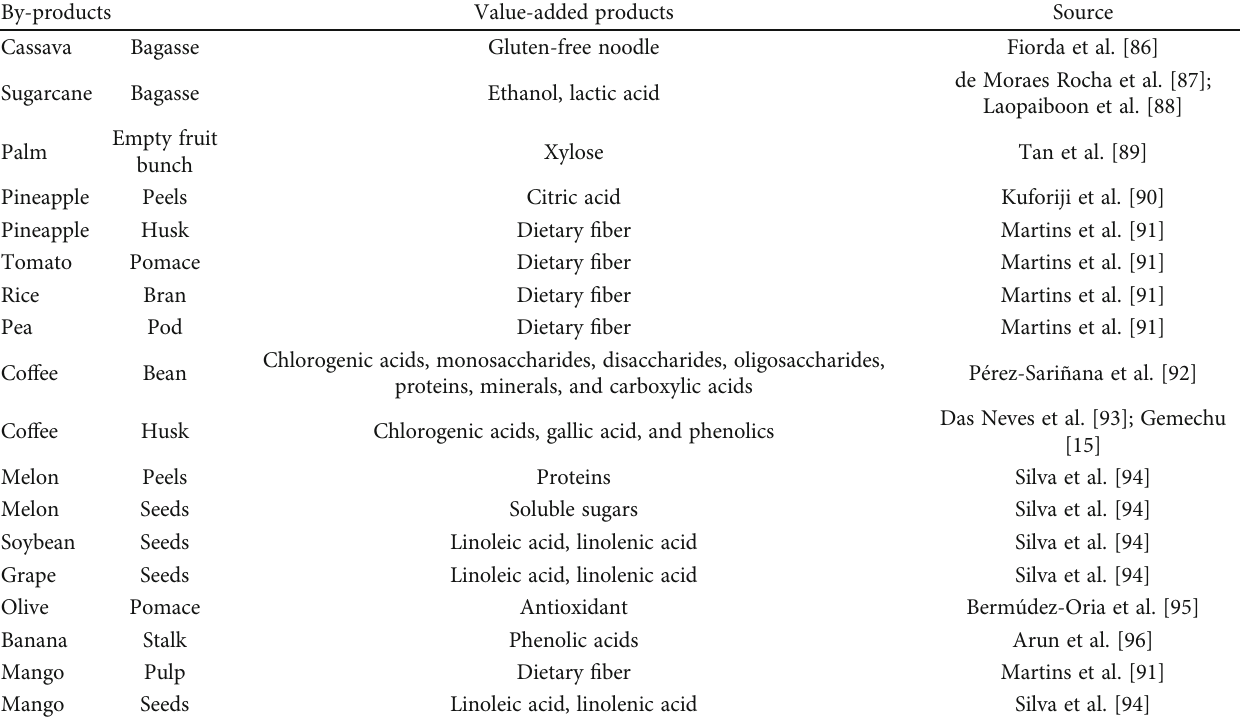
Table 1: By-products with food and pharmaceutical